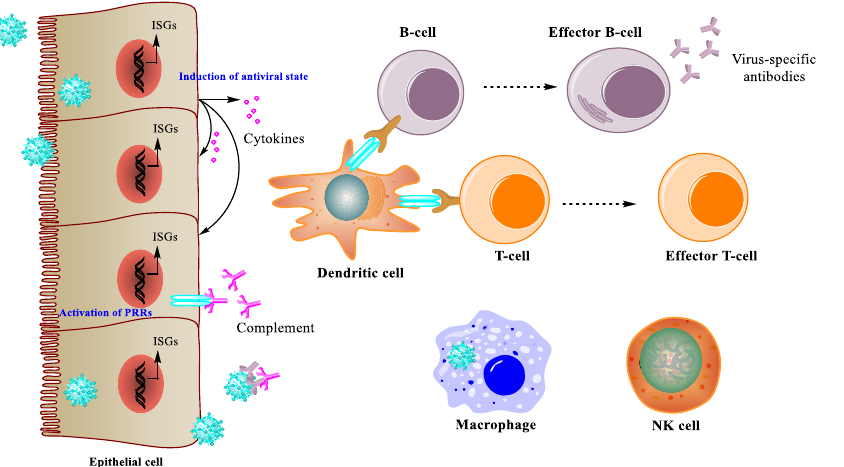
Figure 2. Immune response during viral infections. Table 1. Antiviral effects of natural immunomodulatory